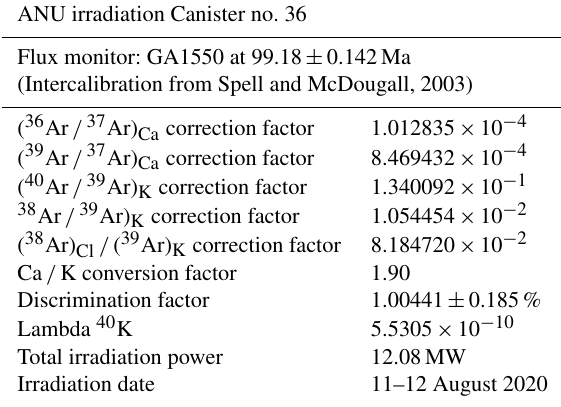
Table B1. ANU Canister no. 36 irradiation information and correc- tion